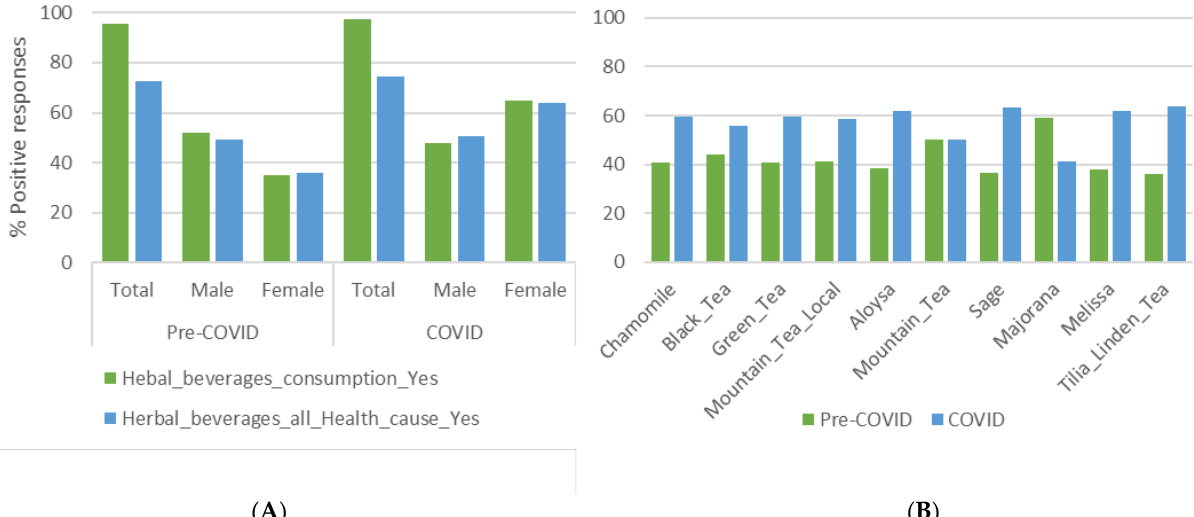
Figure 2. ( A ) Positive responses on the use of MAPs before and after the COVID-19 pandemic was declared, distributed by sex (male; female; total). ( B ) Positive responses on MAPs choice before and after the COVID-19 pandemic was declared.